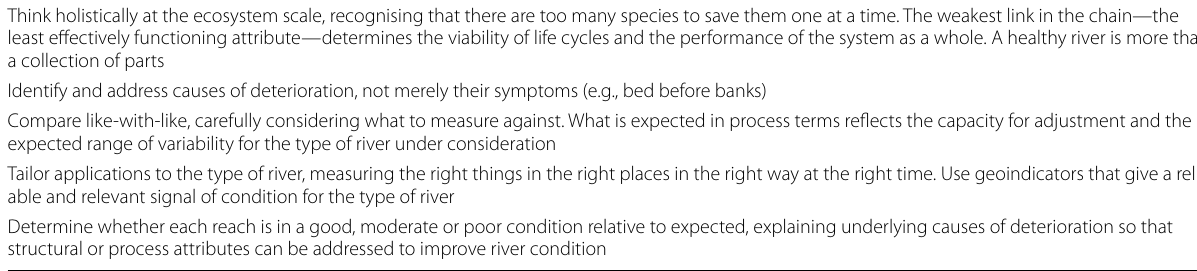
Table 5 Geomorphic principles to assess river condition ( Truth 3